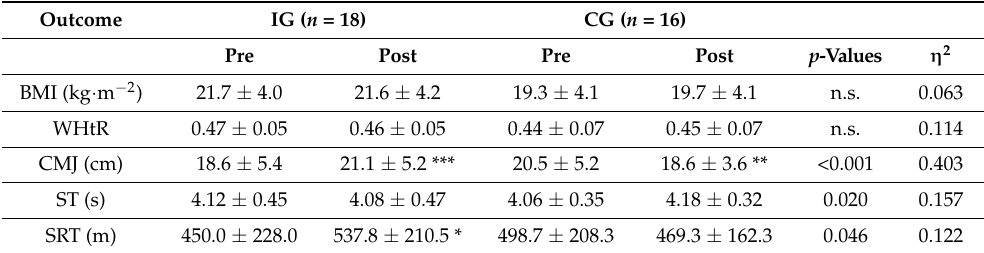
Table 2. Changes in outcomes from before to after intervention for the intervention group (IG) and control group